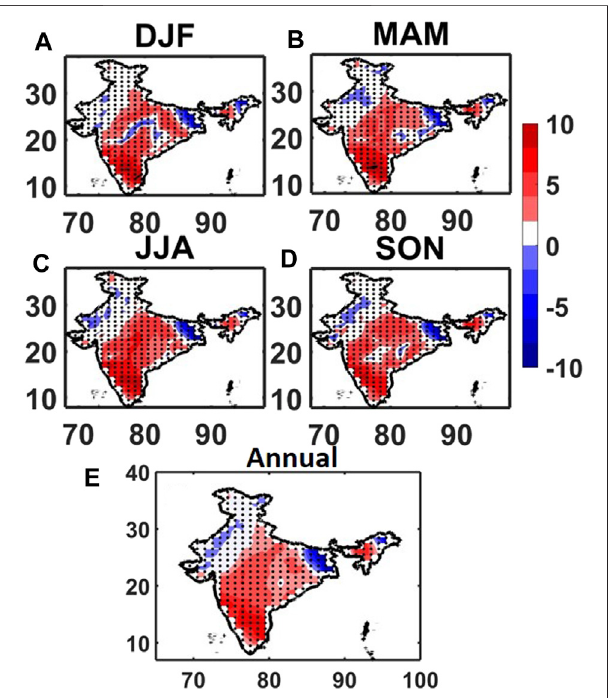
FIGURE 5 | The difference in relative humidity (%) (06 UTC — 09 UTC) over the Indian region for (A) Winter (DJF), (B) Pre-monsoon (MAM), (C) Monsoon (JJA), (D) Post-monsoon (SON), and (E) Annual. Black dots denote 95% signi fi cance level.